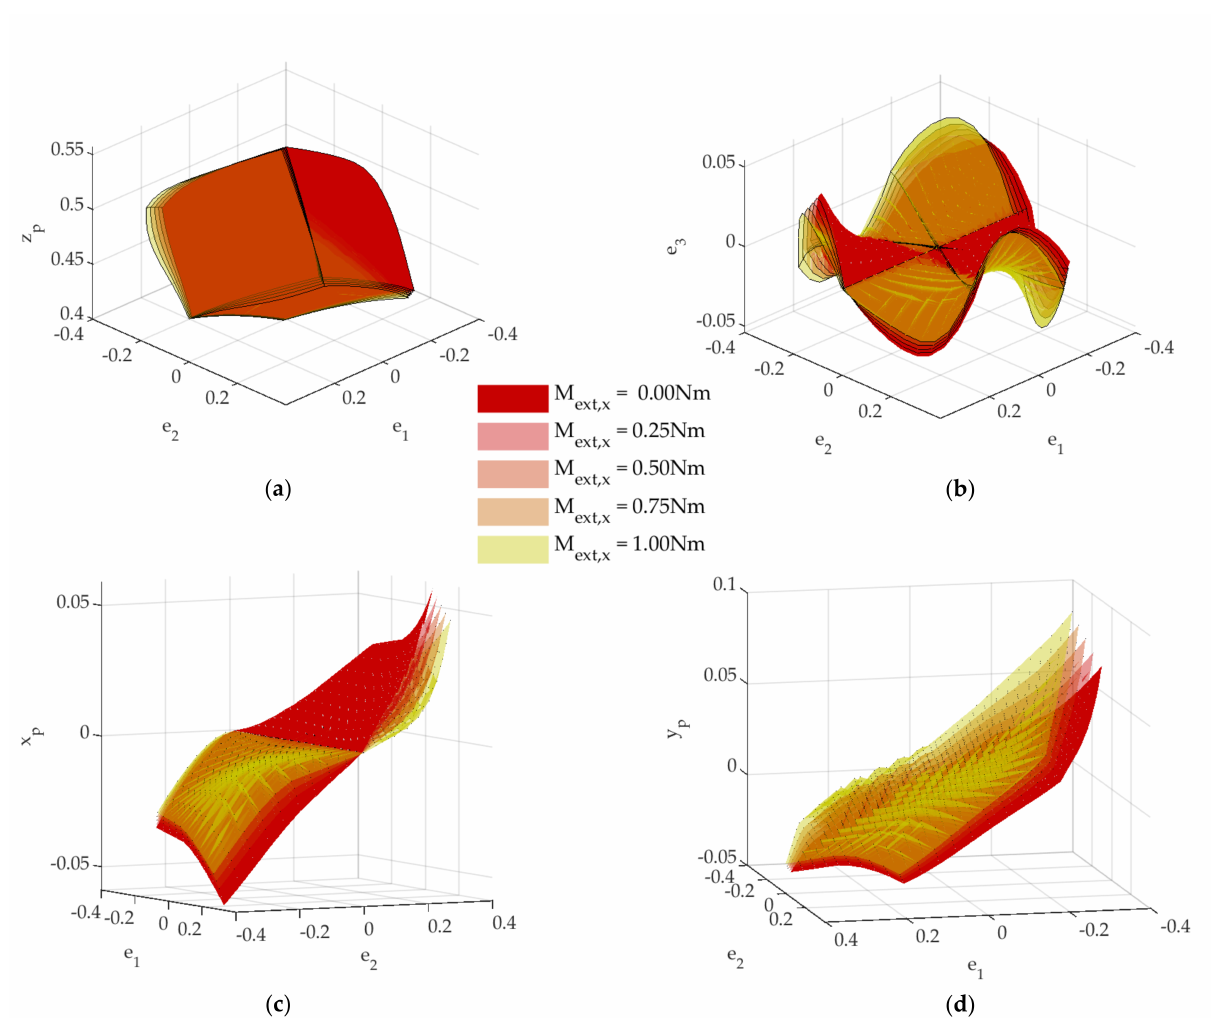
Figure 15. Influence of constant torque around the x axis of the fixed frame on the 3 PFS output parameters e 1 , e 2 , and z p ( a ), and parasitic motions e 3 ( b ), x p ( c ), and y p ( d ). Table 1. Relative RMS error of variables z p , e 3 , x p , and y p between loaded and unloaded case